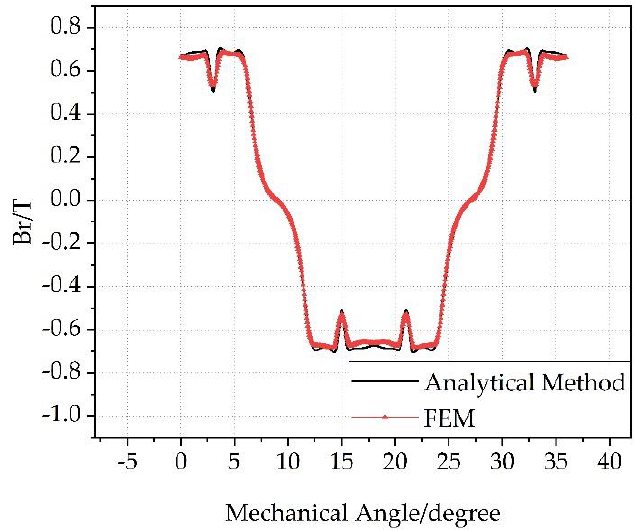
Figure 12. Comparison of the radial component of magnetic field of slotted model.